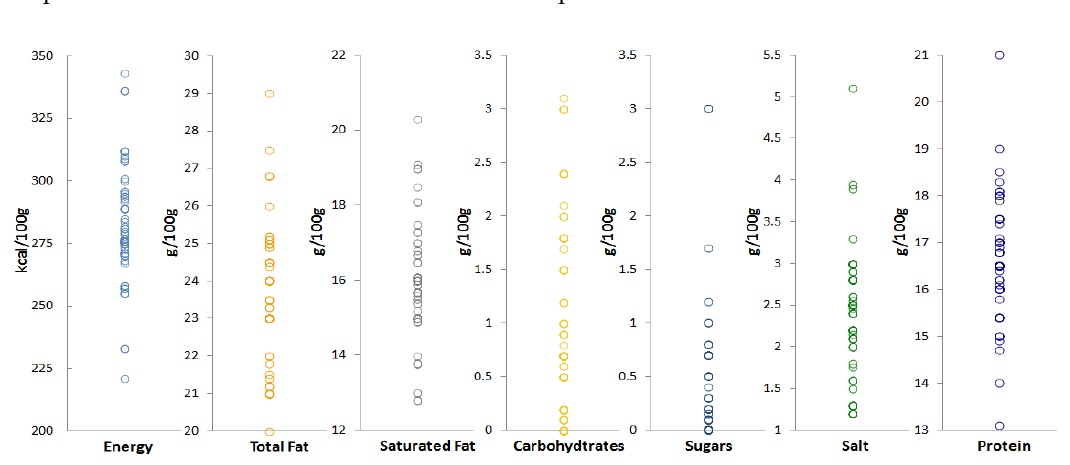
Figure 1. Distributions of energy, total fat, saturated fat, carbohydrates, sugars, salt and protein per 100 g, for prepacked feta cheese products available in the Greek market. Table 2. Descriptive statistics of nutritional characteristics (per 100 g) of prepacked protected designation of origin (PDO) feta cheese products in the Greek market.